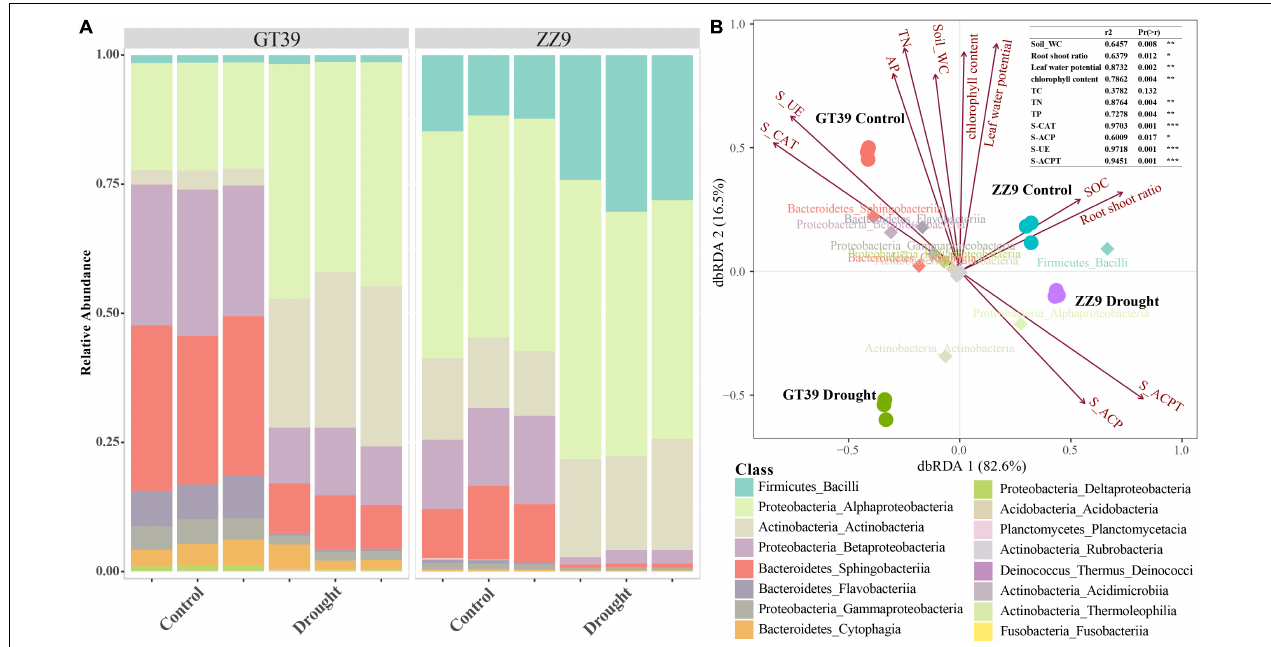
FIGURE 3 | (A) A class-based population structure analysis (relative abundance) of the rhizosphere microbial bacterial communities of ZZ9 and GT39, and the main active populations are displayed. (B) The main active populations and environmental factors affecting the community are analyzed by dbRDA (environmental factors are represented by